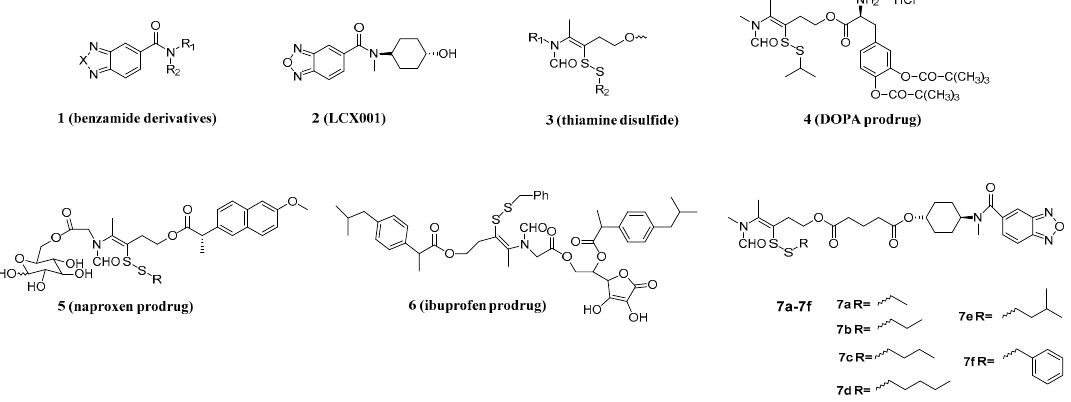
Figure 1. Structure of benzamide derivatives, LCX001, thiamine disulfide, DOPA prodrug, naproxen prodrug, ibuprofen prodrug and the designed prodrugs of LCX001.